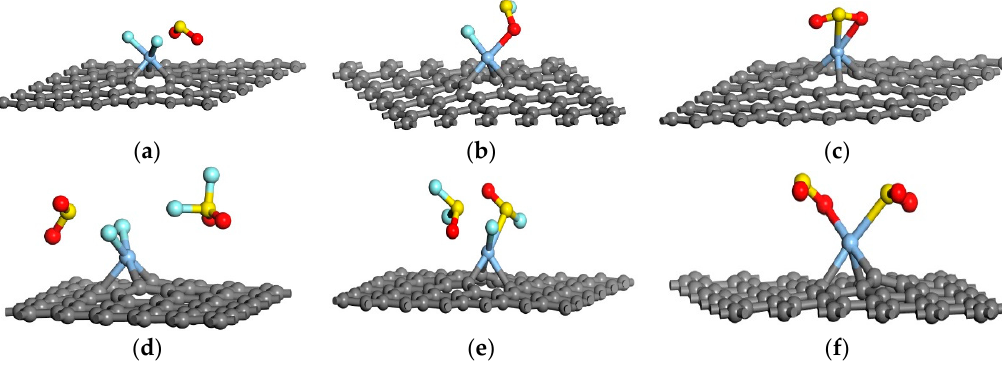
Figure 6. Most stable configurations of gas molecules adsorbed on the Ag-graphene ( a ) SO 2 F 2 ; ( b ) SOF 2 ; ( c ) SO 2 ; ( d ) double SO 2 F 2 ; ( e ) double SOF 2 ; ( f ) double SO 2 . Reproduced with permission from reference [59]. Copyright 2016 Sensors.